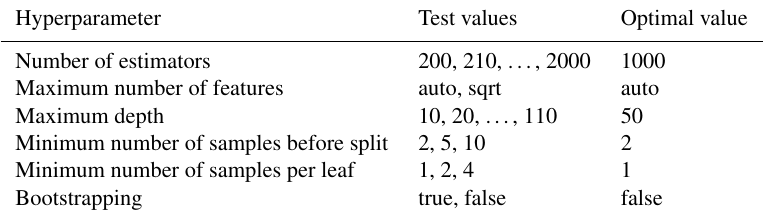
Table 5. Hyperparameter choices considered for the RF classifier.